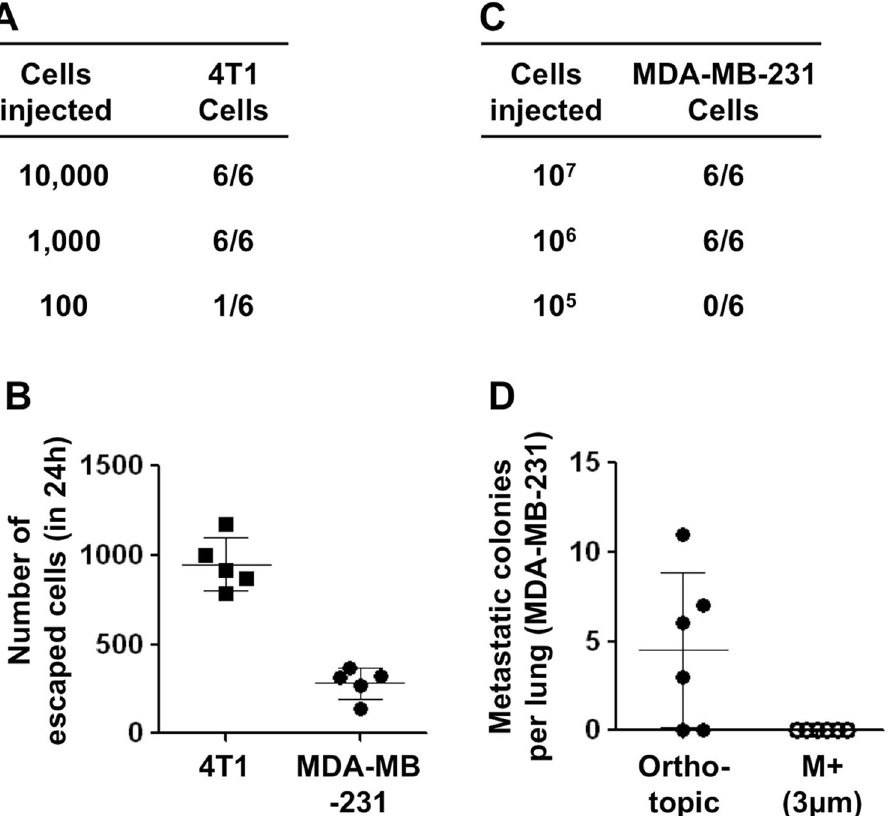
Figure 7. Validate the fuzzy prediction model using the experimental data. ( A,C ) Tumorigenic ability assay using 4T1 and MDA-MB-231 cells (n = 6). ( B ) Count the number of tumor cells that escaped from the membrane-wrapped tumor in 24 h (n = 5). ( D ) Comparison of lung metastatic colonies from the orthotopic and membrane-wrapped MDA-MB-231 tumor (n = 6). The data are presented as scatter plots with means ±